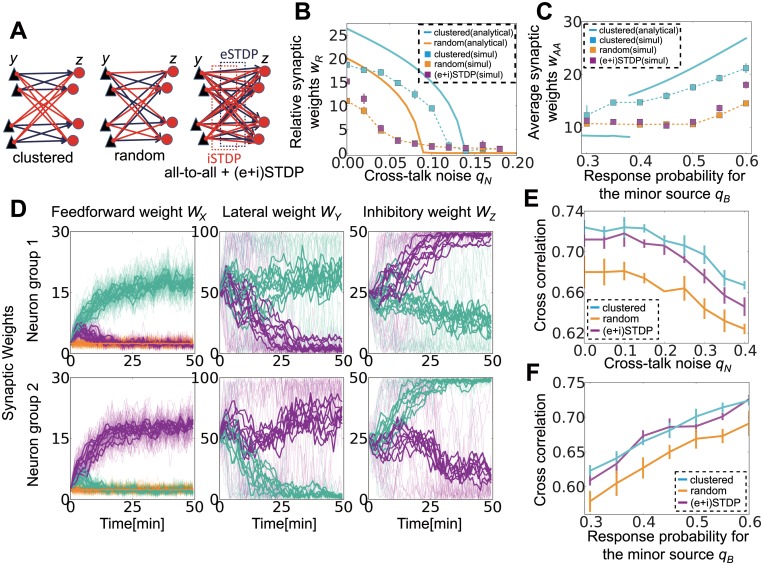
Lateral connection structuring by excitatory and inhibitory spike-timing-dependent plasticity (STDP).(A) Schematic figures of connections between the output layer and the lateral layer. In the simulation, each layer consists of 20 neurons. (B) The effect of crosstalk noise on different lateral structures. Analytical results are shown as bold lines, and the results from simulations are shown as dotted lines. (C) Minor source detection with different lateral structures. Because the specialization index is not well defined for a network with random lateral connections, the average synaptic weights from source A to those output neurons that prefer source A were measured instead. (D) Synaptic weight development at three connections. In the left and right columns, panels show synaptic weights of excitatory/inhibitory synapses projected to the neuron group 1 (top) and group 2 (bottom). In the middle graph, panels correspond to excitatory synapses projected from the neuron group 1 (top) and group 2 (bottom). In all panels, thin lines indicate the development of individual synapses, thick lines represent average weights onto output neurons, and colors indicate A-neurons (blue), B-neurons (red), and Background-neurons (orange). (E, F) Performance of the network with different lateral structures in noisy signal detection (E) and minor signal detection (F). Here (and only here), a pre-learned network is used to investigate responses for various inputs.